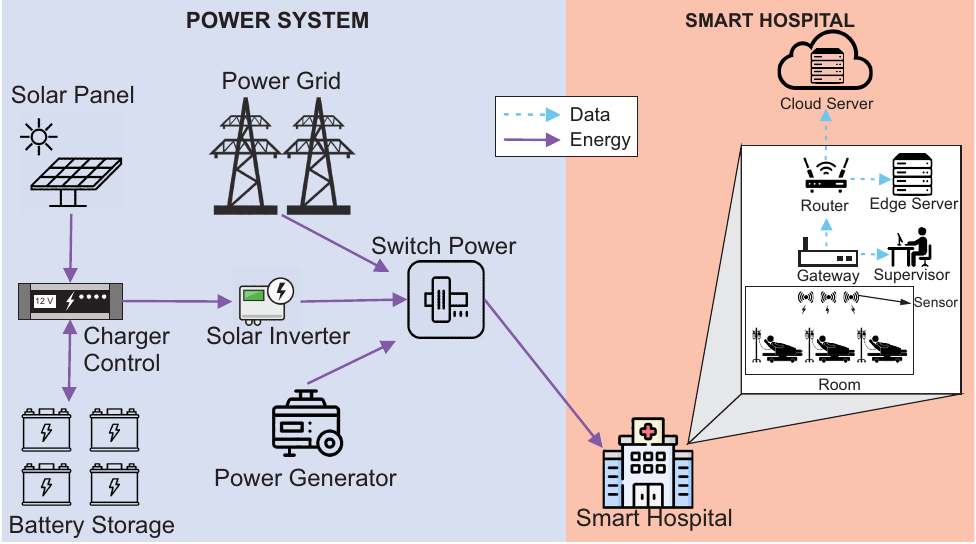
Figure 1. Proposed architecture of a smart hospital